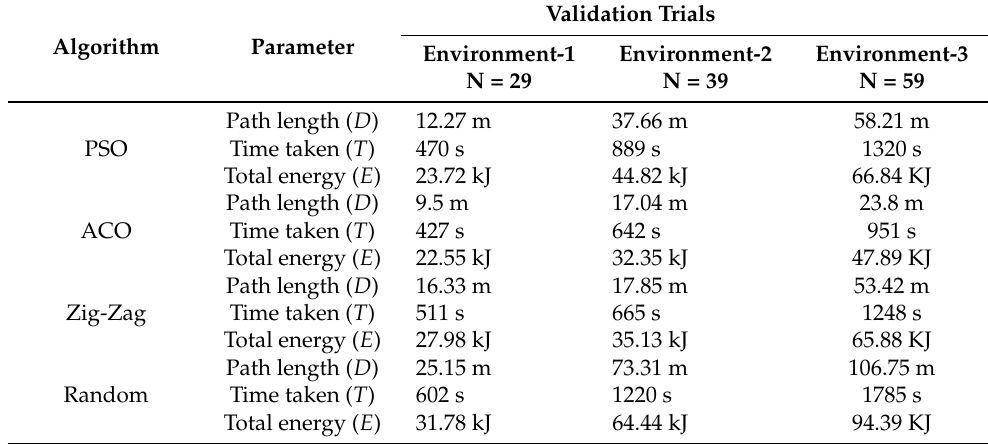
Table 3. The overall observations from